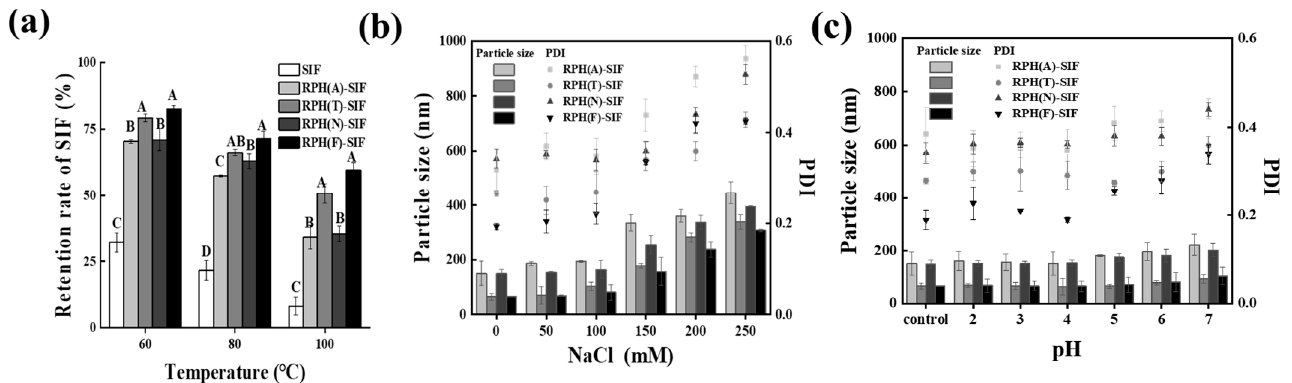
Figure 5. The effects of temperature ( a ) on the retention of SIF in nanoparticles and the effects of ionic strength ( b ) and pH ( c ) on the particle size and PDI of SIF-loaded RPHs. A–D Different superscript le tt ers represent a signi fi cant di ff erence ( p < 0.05).